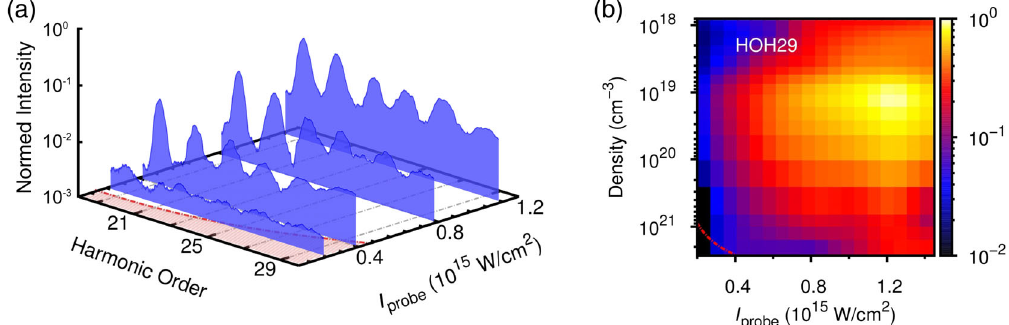
FIG. 4. Controlling the electronic excursion with the driving intensity. (a) Spectra of harmonic radiation as a function of the intensity of the probe pulse for a fixed density of the target. No harmonic radiation is observed within the red area, where the electronic displacement is larger than the mean interparticle distance. The displacement is reduced with increasing intensity, and the emission process turns from incoherent to coherent. (b) Signal of the 29th harmonic order as a function of the target density and the intensity of the driving pulse. A perturbation of the trajectories becomes more probable for densities higher than the position of the maximum in intensity. Again, no harmonic radiation is detected for densities and intensities where the electronic excursion matches the mean interparticle distance assigned to the short trajectory ( ρ > ρ s , dashed red